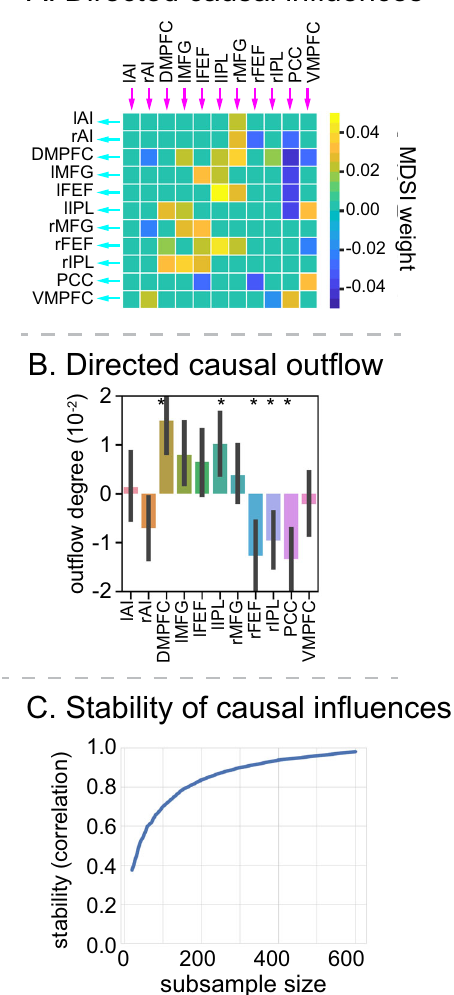
Fig. 5 Working-memory load-dependent dynamic causal in fl uence and net out fl ow. A MDSI analysis revealed links with signi fi cantly greater directed causal in fl uences between SN, FPN, and DMN nodes in the 2-back, compared to the 0-back, working-memory task condition ( p < 0.05, FDR- corrected, two-sided t -test). n = 737 participants. B The DMPFC and lIPL showed signi fi cantly higher directed causal out fl ow in the 2-back, compared to the 0-back, task condition. In contrast, the PCC, rFEF and rIPL showed signi fi cantly higher directed causal in fl ow in the 2-back, compared to the 0-back, task condition ( p < 0.05, FDR-corrected, two-sided t -test). n = 737 participants. Data are presented as mean± SEM. C Stability analyses revealed highly stable multivariate patterns of causal in fl uences between SN, FPN, and DMN nodes in 2-back versus 0-back ( r >0.8 with samples >200). X -axis is the subsample sizes, ranging from 20 to 600. Y -axis is the stability measures, which is the correlation of multivariate causal interaction patterns between subsamples and original dataset. lAI left anterior insula, rAI right anterior insula, DMPFC dorsomedial prefrontal cortex, lMFG left middle frontal gyrus, rMFG right middle frontal gyrus, lFEF left frontal eye fi eld, rFEF right frontal eye fi eld, lIPL left intraparietal lobule, rIPL right intraparietal lobule, PCC posterior cingulate cortex, VMPFC ventromedial prefrontal cortex. Source data are provided as a Source data fi